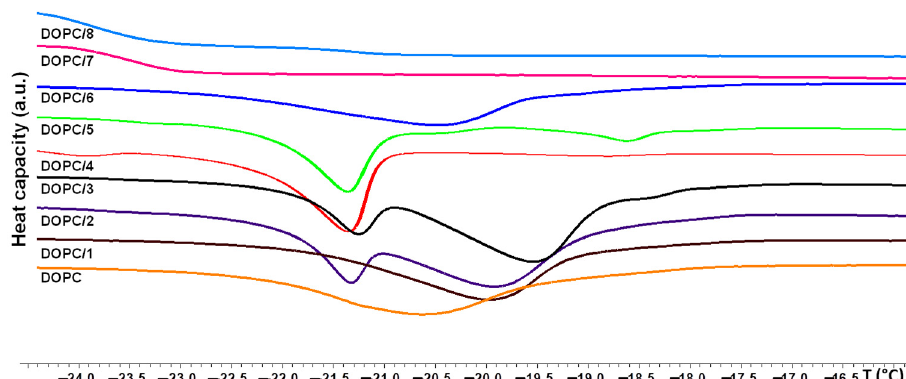
Figure 10. Thermograms of DOPC/quinolines MLV: DOPC, yellow line; DOPC/ 1 , brown line; DOPC/ 2 , purple line; DOPC/ 3 , black line; DOPC/ 4 , red line; DOPC/ 5 , green line; DOPC/ 6 , blue line; DOPC/ 7 , pink line; DOPC/ 8 , light blue line. Scan rate is 1 °C/min.